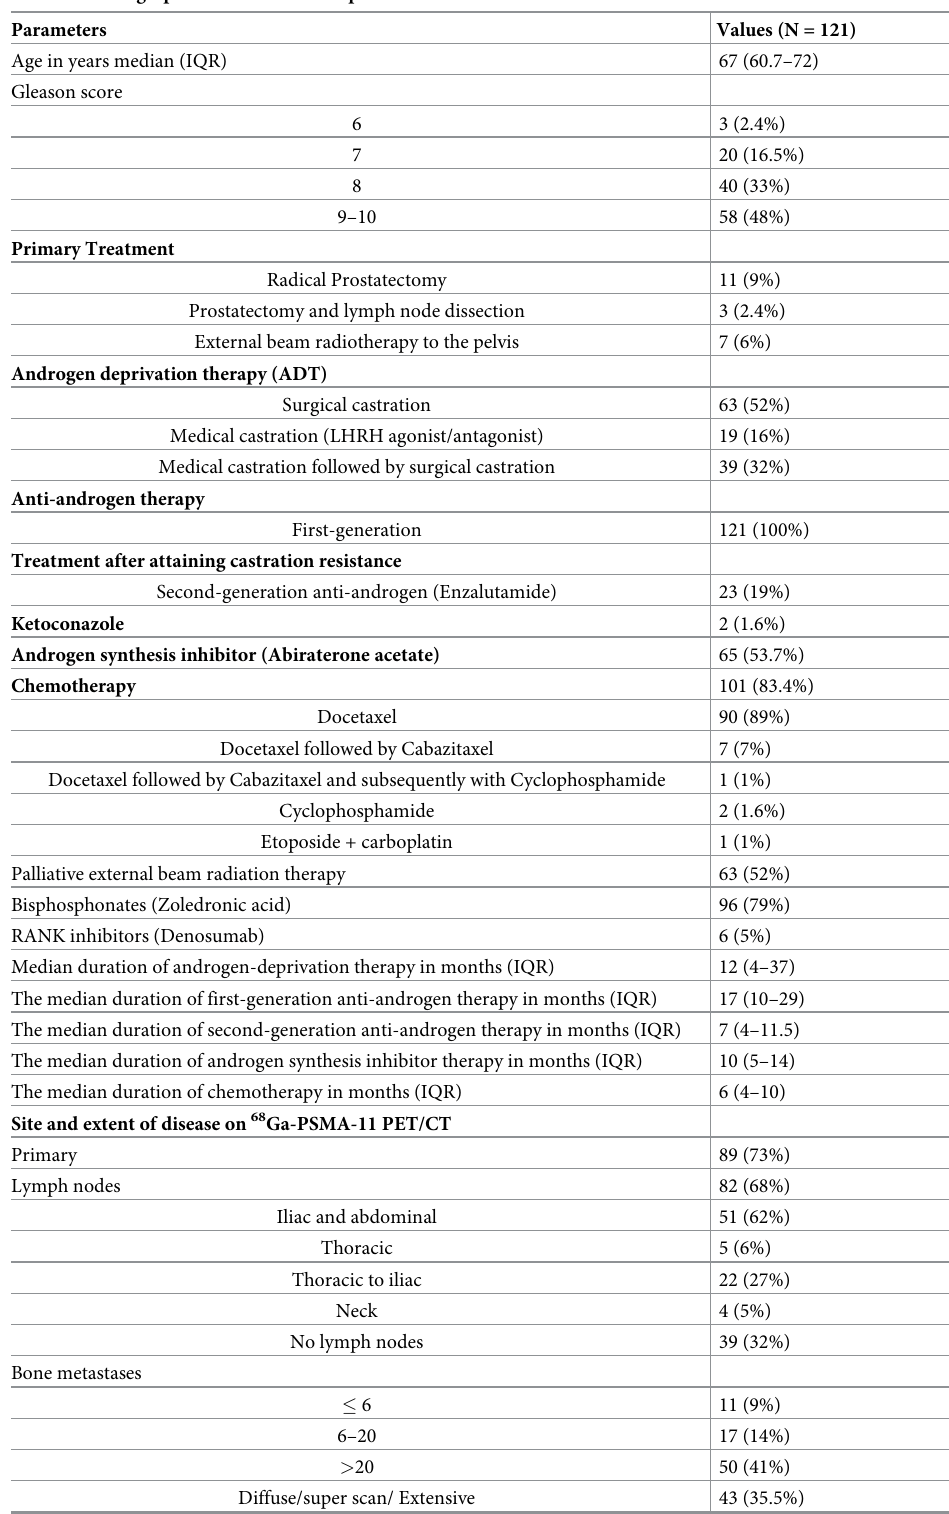
Table 1. Demographic characteristics of